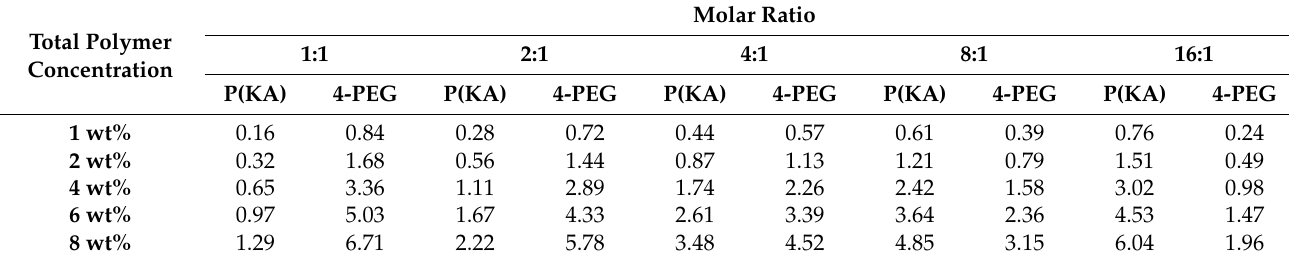
Table 1. A summary of the polymer concentrations of the P(KA) and 4-PEG-SG used in the preparation of the library of hydrogel solutions to achieve the total polymer concentrations of 1 wt%, 2 wt%, 4 wt%, 6 wt% and 8 wt%.